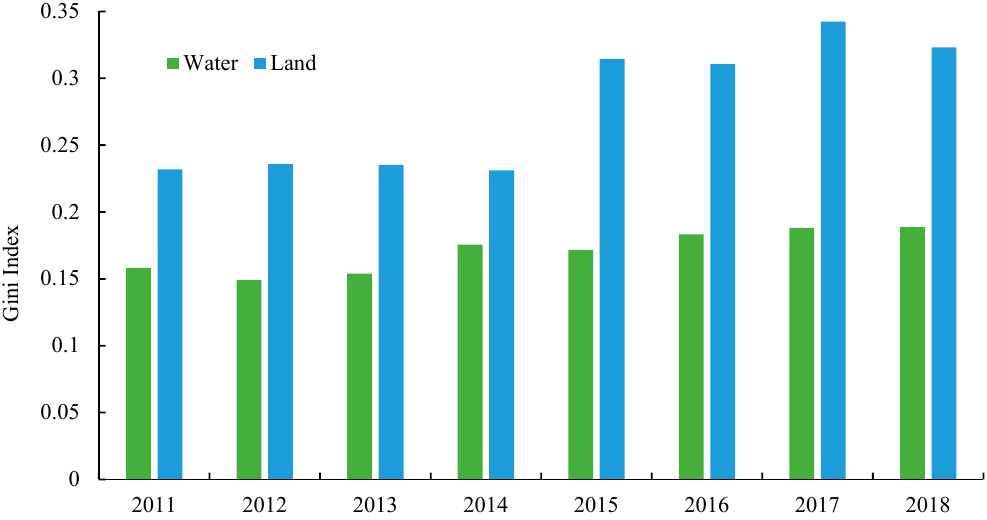
Figure 7. Gini Index of water resources, land resources and GDP in Chengdu–Chongqing Economic Circle from 2011 to